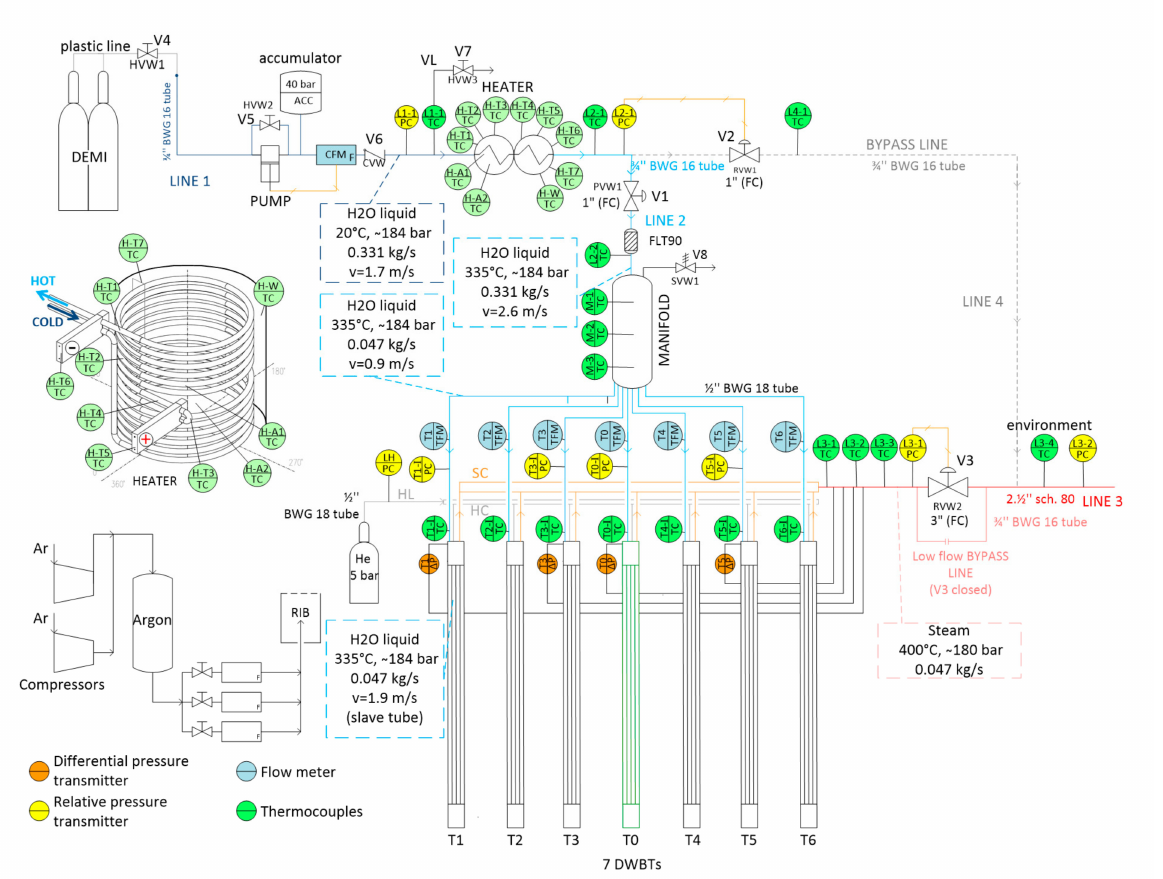
Figure 3. Piping and instrumentation diagram of the HERO SGBT secondary water loop. ACC: Accumulator; CFM: Coriolis Flowmeter; CVW: Check Valve Water; FC: Fail Closed; FLT: Filter; HVW1: Hand Valve Water; PVW: Pneumatic Valve Water; RIB: Riser Bottom; RVW2: Reguation Valve Water; SVW: Safety Valve